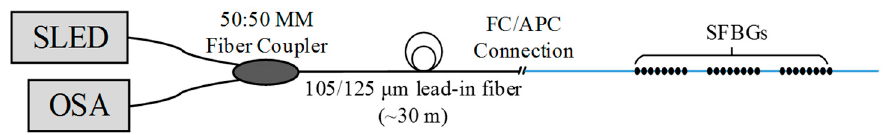
Figure 4. Scheme for the interrogation system. Note: SLED = superluminescent light emitting diode; OSA = optical spectrum analyzer; MM = multimode; FC/APC = Ferrule Connecter/Angled Physical Contact.